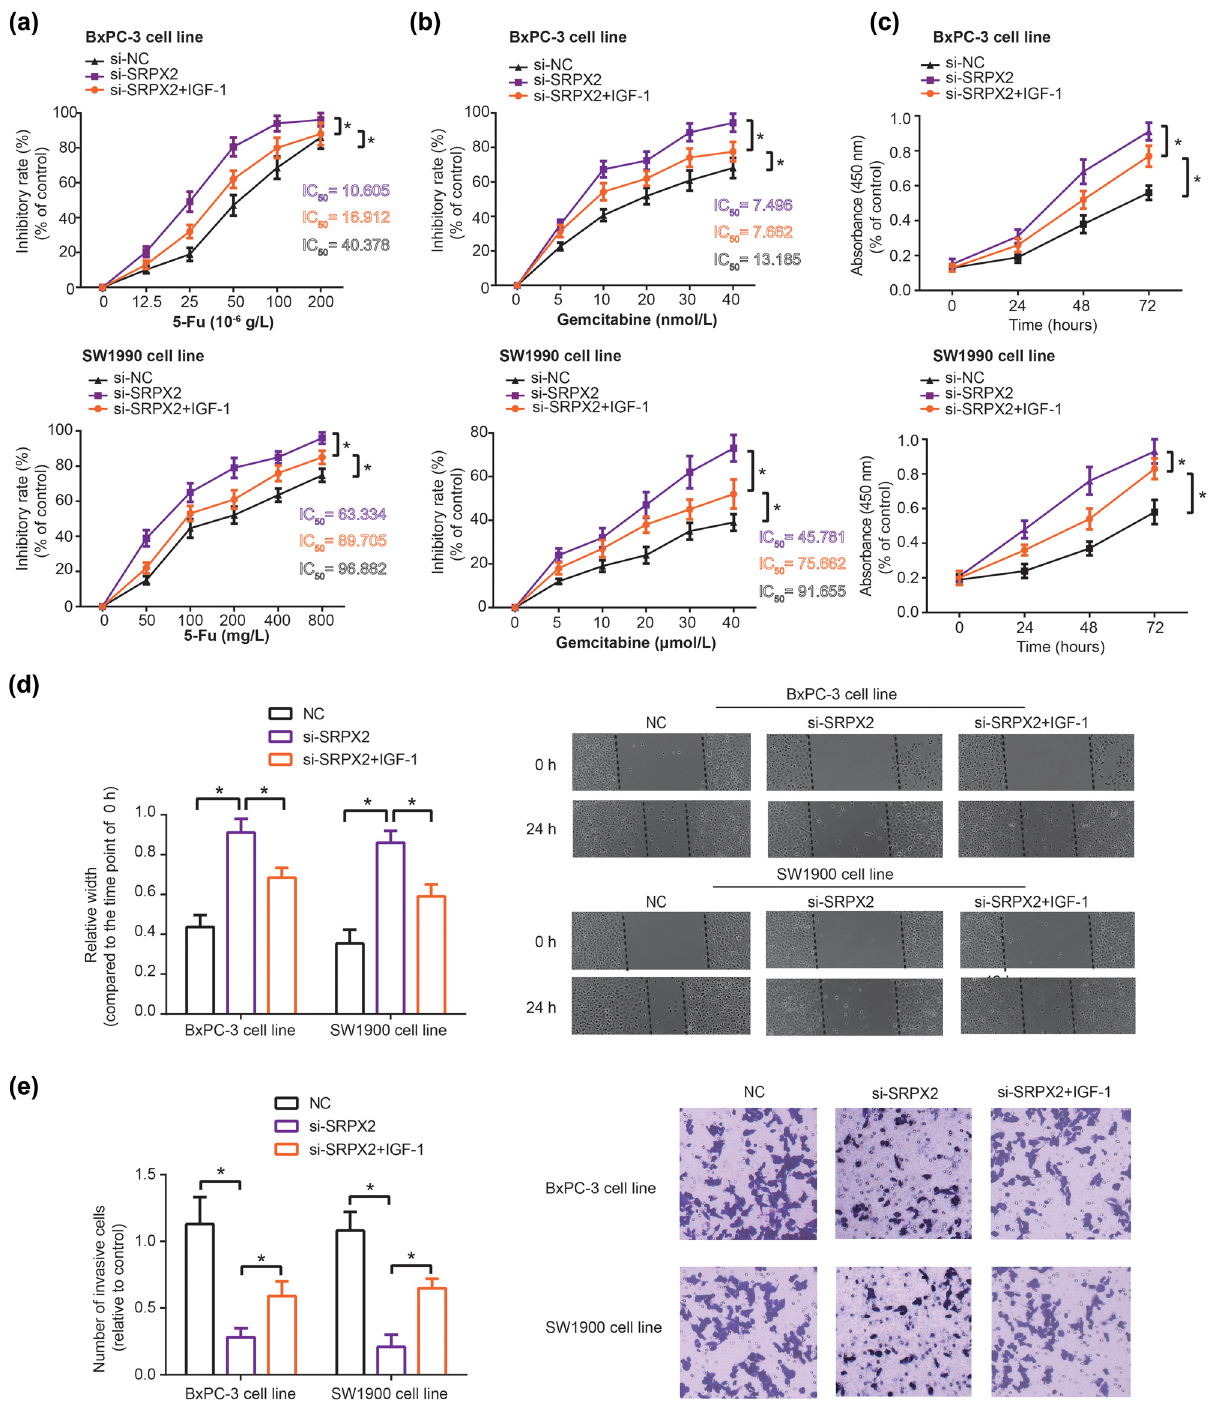
Figure 4: Chemo - resistance ( a and b ) , proliferation ( c ) , migration ( d ) and invasion ( e ) of SW1990 and BxPC - 3 cell lines were evaluated among NC, si - SRPX2 and si - SRPX2 + IGF - 1 groups. * P <